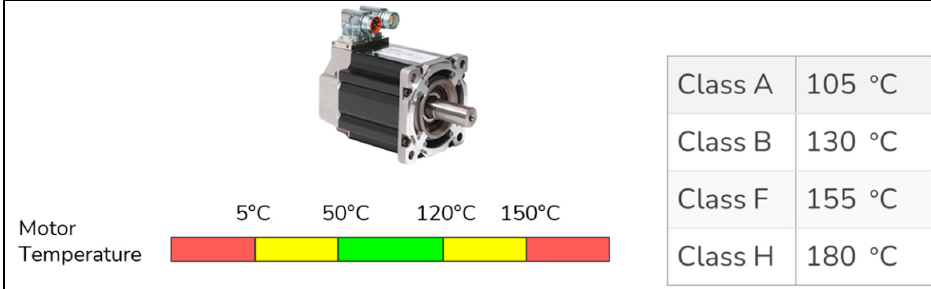
Figure 3. The visual representation of the optimum temperature ranges of the chosen motor.